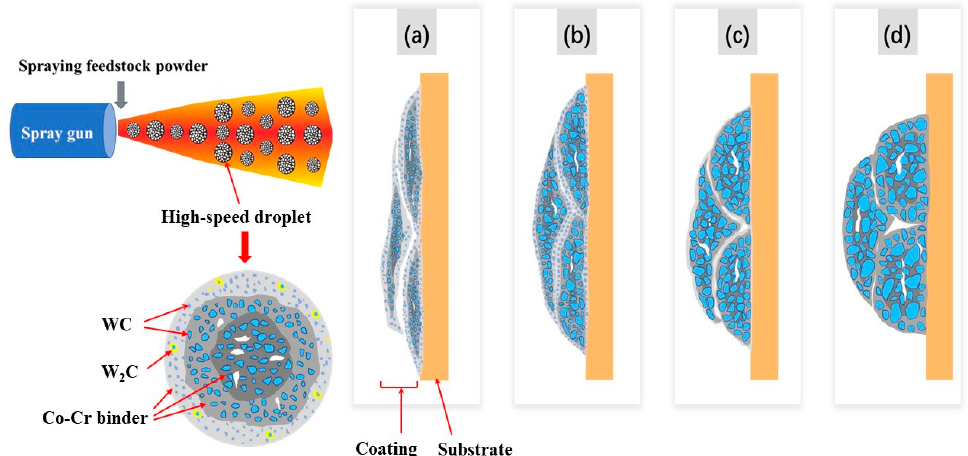
Figure 5. Schematic of the formation of the lamellar-like structures in HVOF sprayed WC–10Co–4Cr coatings with different WC particle sizes: ( a ) N; ( b ) B1; ( c ) M; ( d ) B2.